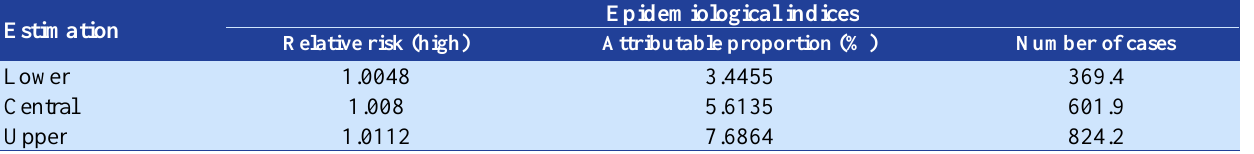
Table 5. The estimation of relative risk indices, attributable proportion, and number of cases of respiratory tract diseases attributed to PM10 (outpatient treatment) (BI = 1260) in Kermanshah in